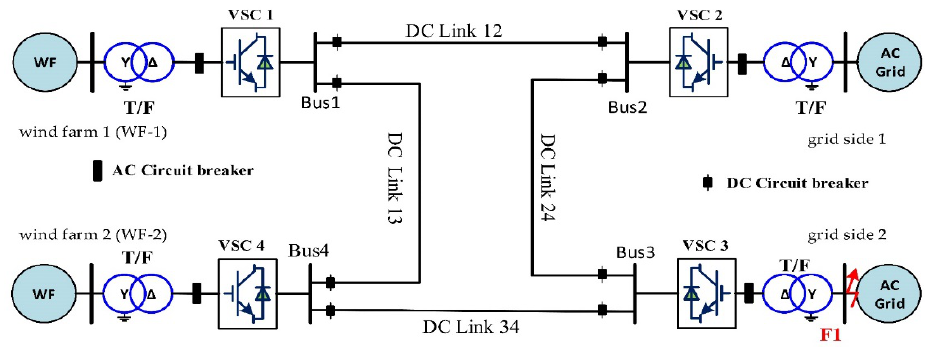
Figure 1. A four-terminal, VSC-based MTDC test grid.